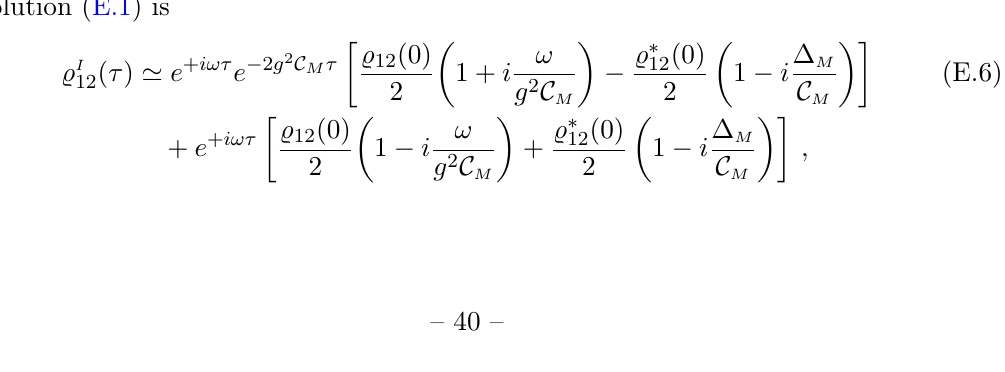
table 1. To make this explicit, we write down table 5 exploring the size of ! C 0 various regimes (showing that only ! (cid:28) a is allowed). For completeness we also (cid:12)ll out table 6 with all the inequalities (E.2) in the ! (cid:28) a regime. We also point out that the last row of table 6 tells us that !=a is so small that !=a (cid:28) g 2 (cid:28) 1. We note (cid:12)nally that